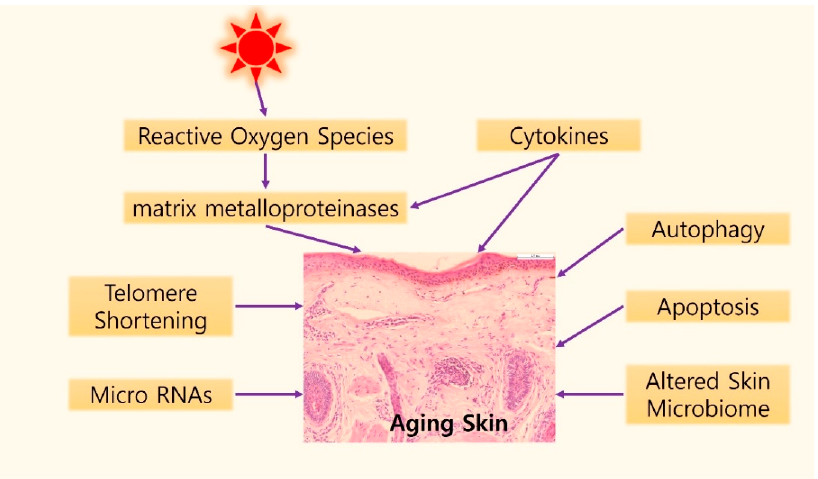
Figure 3. Graphical illustration of possible mechanisms of skin aging. Gradual shortening of telomeres can induce the cellular senescence caused by intrinsic aging. UV exposure induces telomere shortening by producing reactive oxygen species (ROS) in the skin. ROS accumulation results in DNA damage and activation of two major regulatory signaling pathways, the mitogen-activated protein kinase (MAPK) and nuclear factor kappa B (NF- κ B) signaling pathways, which induce matrix metalloproteinases activation. In addition, cytokines, such as tumor necrosis factor- α , interleukin (IL)-1, IL-6, IL-18, and Cysteine-rich protein 61 are another important element in the skin aging process. Autophagy and apoptosis might be associated with skin aging. In the field of epigenetics, specific micro RNAs have been reported in aged skin. Finally, studies on the role of the microbiome changed with aging process are being actively conducted.